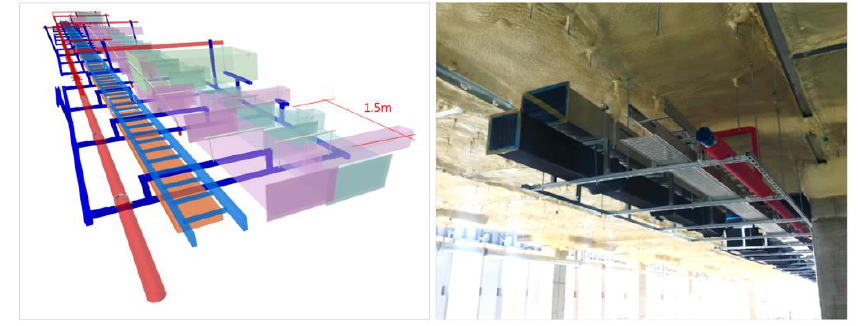
Figure 5. Type E: Frames with only the lower support retained (supporting interval: 1.5 m).